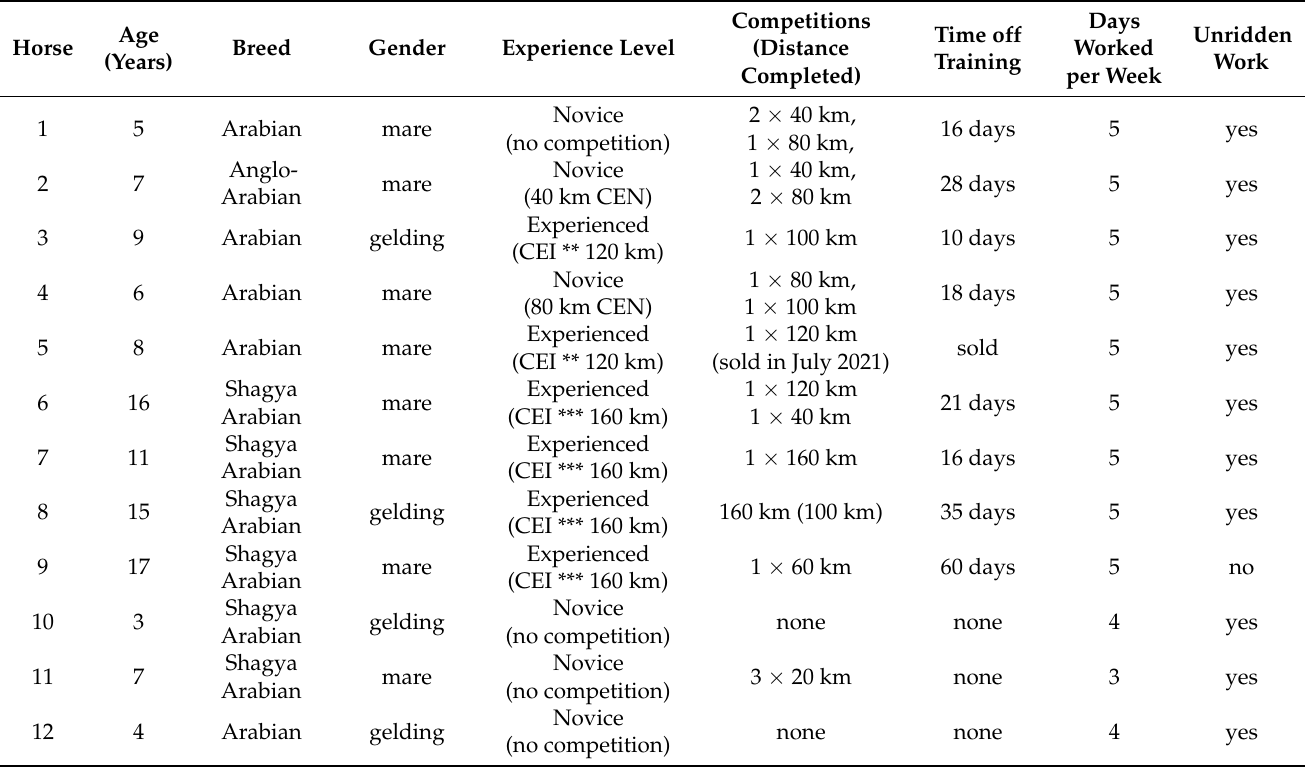
Table 2. Signalment and experience of 12 endurance horses and their competitions and days off train- ing during the study period of approximately six months. Experience level was recorded at the start of the study. Novice—horses that had never competed at a distance longer than 80 km at a national level, experienced—horses that had completed at least two ≥ 120 km international endurance